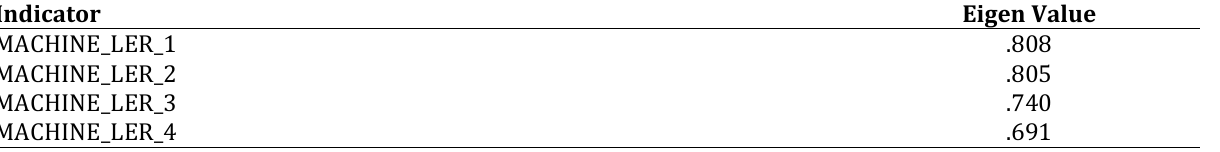
Table 5: Eigen scores of the first principal component